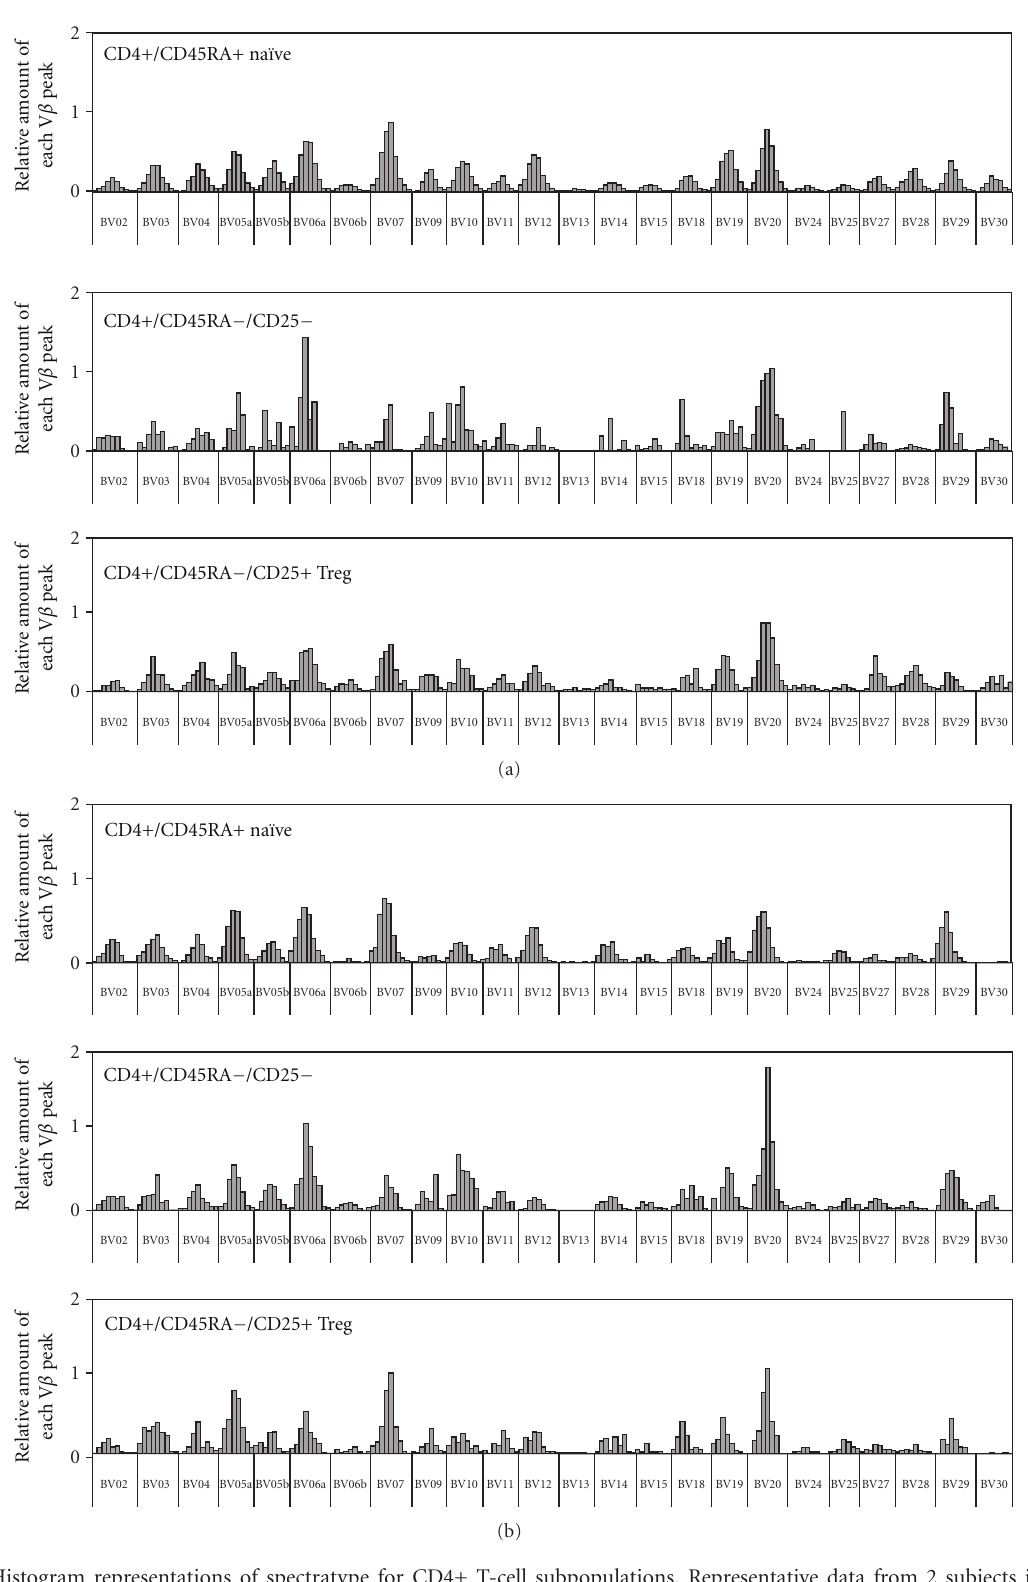
Figure 6: Histogram representations of spectratype for CD4+ T-cell subpopulations. Representative data from 2 subjects is displayed. Distribution of peak lengths for all V β families for an 18-year-old with no surgery (a) and a 2-year-old after multiple prior surgeries and low TREC. (b) Relative Vb lengths for na¨ıve (CD45RA+), memory (CD45RA − ), or non-na¨ıve Treg (CD45RA − CD25+) CD4+ T cells are